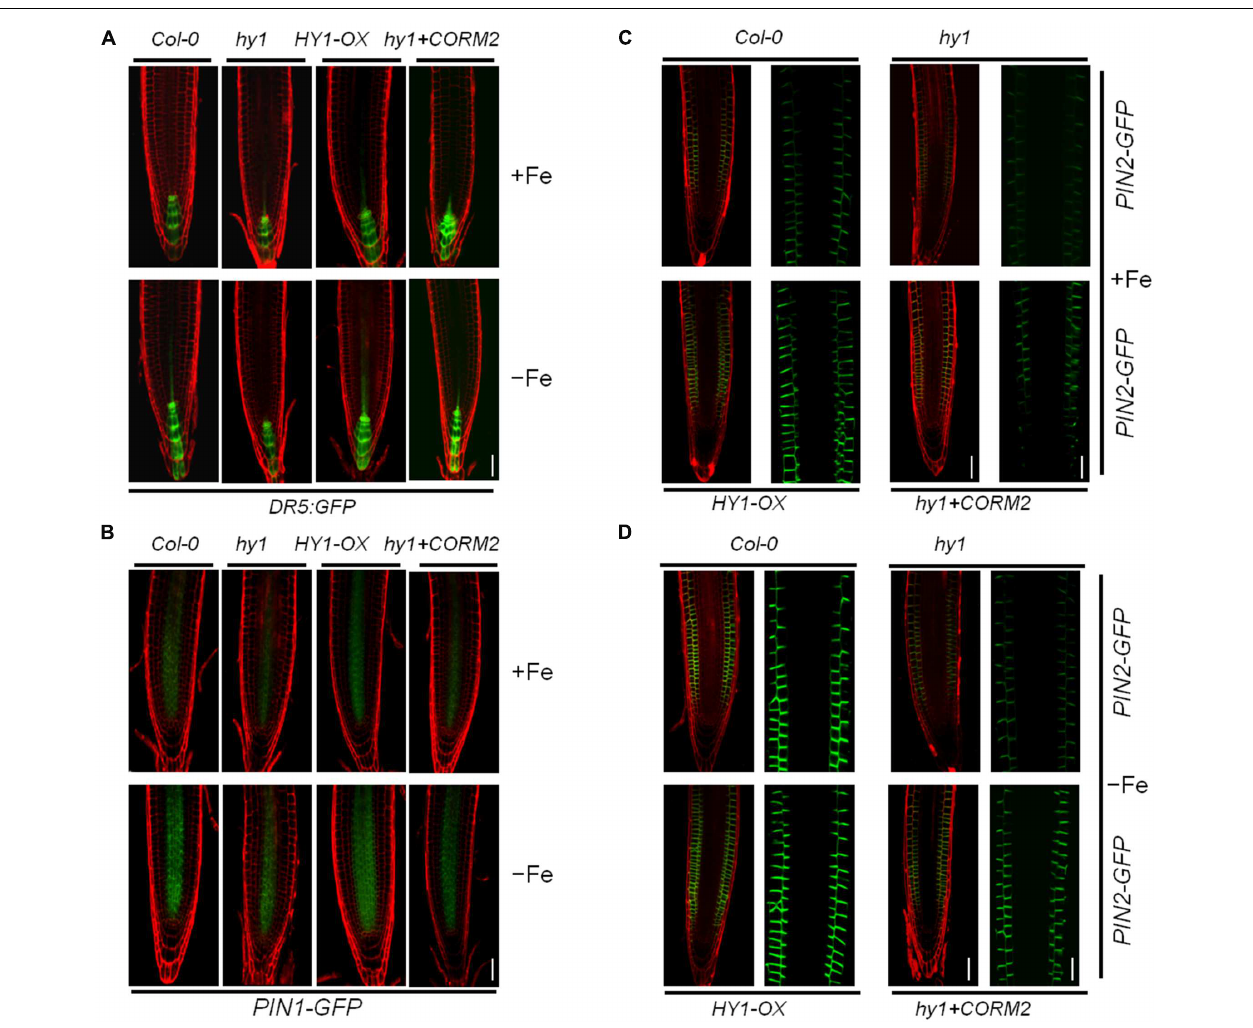
FIGURE 4 | Iron deficiency stress altered the expression patterns of Dr5: GFP , PIN1-GFP, and PIN2-GFP in the root tip. (A,B) Confocal images of the DR5:GFP reporter (A) and PIN1-GFP (B) in Col-0, hy1 , and HY1-OX lines treated with + Fe, –Fe, or –Fe + 100 nM CORM2 for 1 day. (C,D) Confocal images of the PIN2-GFP reporter in Col-0, hy1, and HY1-OX lines treated with + Fe, –Fe, or –Fe + 100 nM CORM2 for 3 days. Left: fluorescence images of the root tip; Right: enlarged